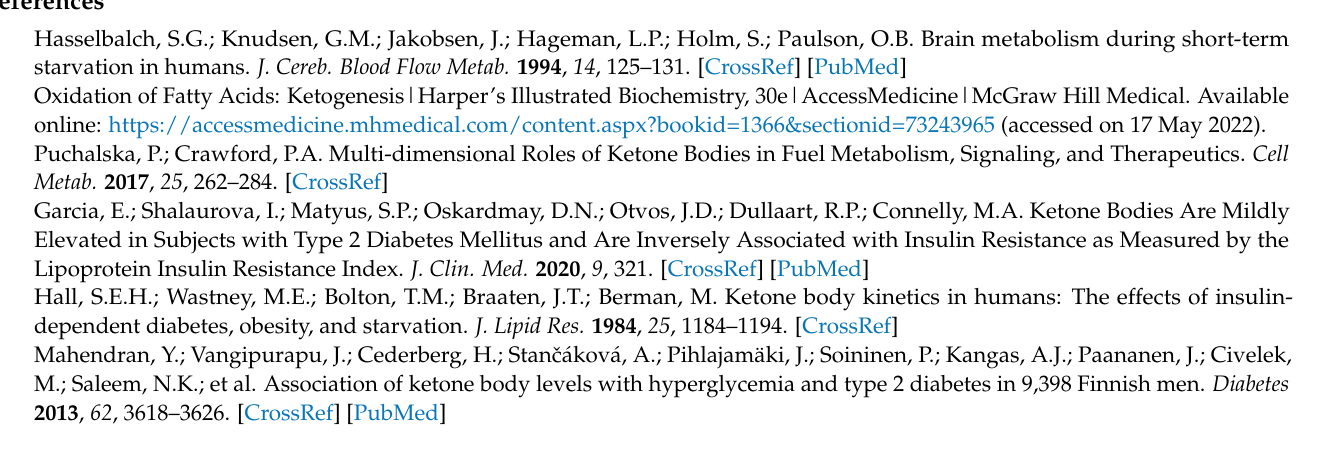
Table S2: Longitudinal associations between fasting plasma KB and annual fasting glucose change in linear mixed model analyses in PREVEND; Figure S1: Graphical illustration of the association between KB according to tertiles at baseline and HbA1c at baseline and over time